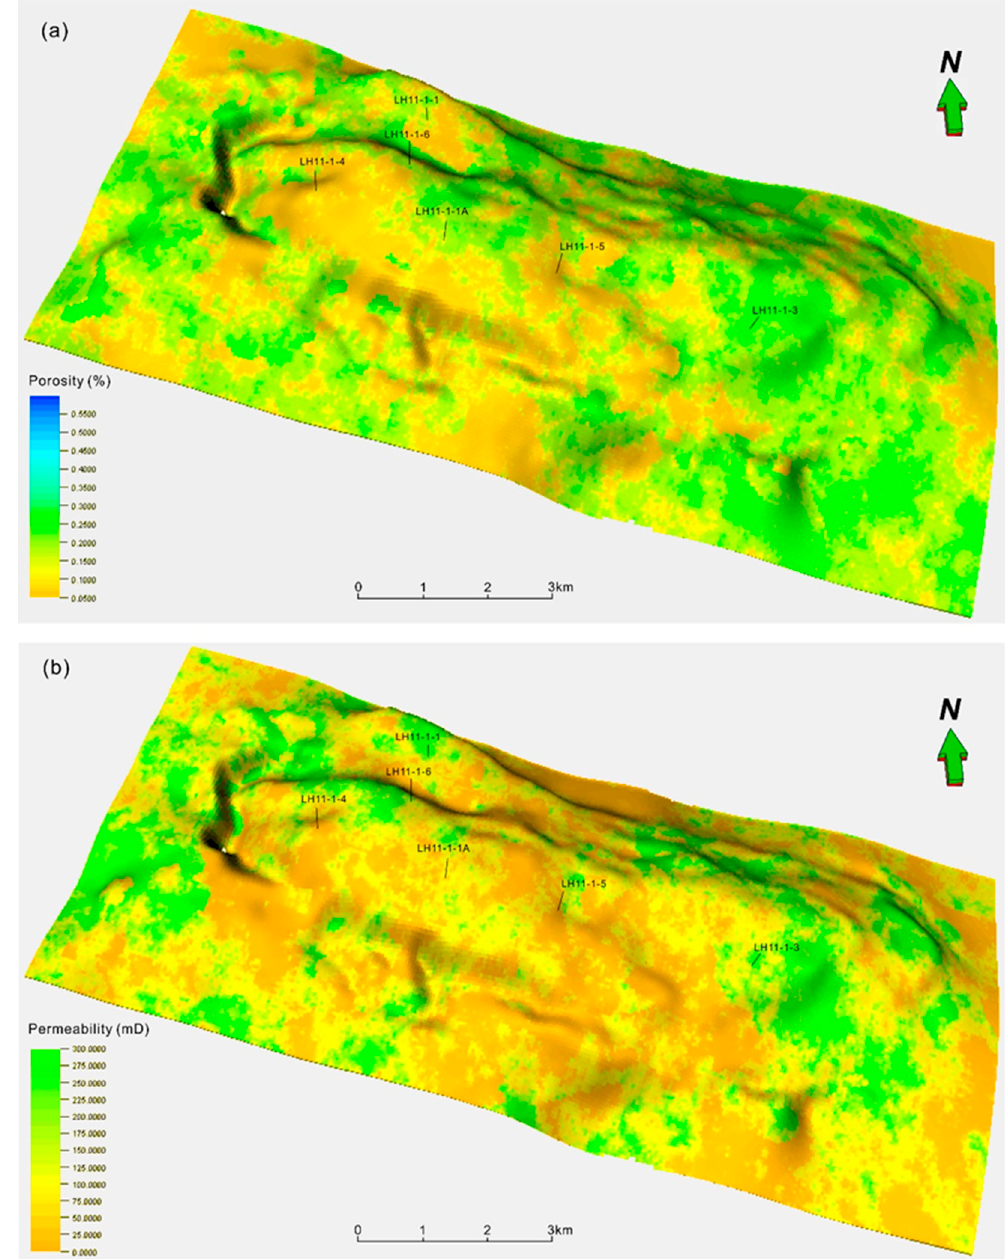
Figure 4. The 3D property models of porosity ( a ) and permeability ( b ) built for the LH oilfield (Modified after Li et al., 2019 [28]).